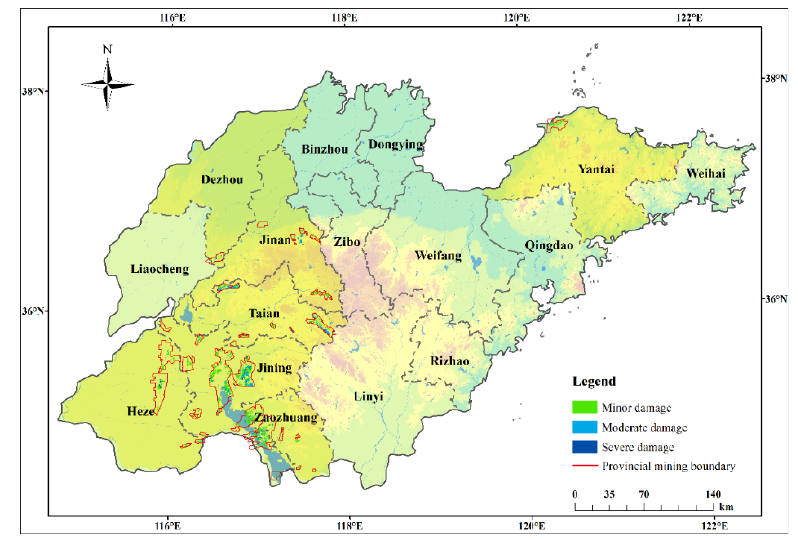
Figure 4. Prediction of mining subsidence land by 2025.